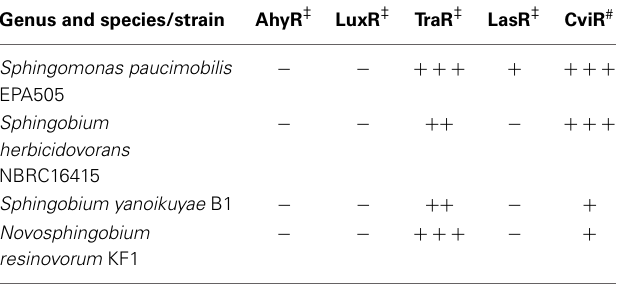
Table 2 | Production of N -acyl-homoserine lactones by four newly sequenced strains of the Sphingomonas, Sphingobium and Novosphingobium group assayed by five AHL-dependent biosensor